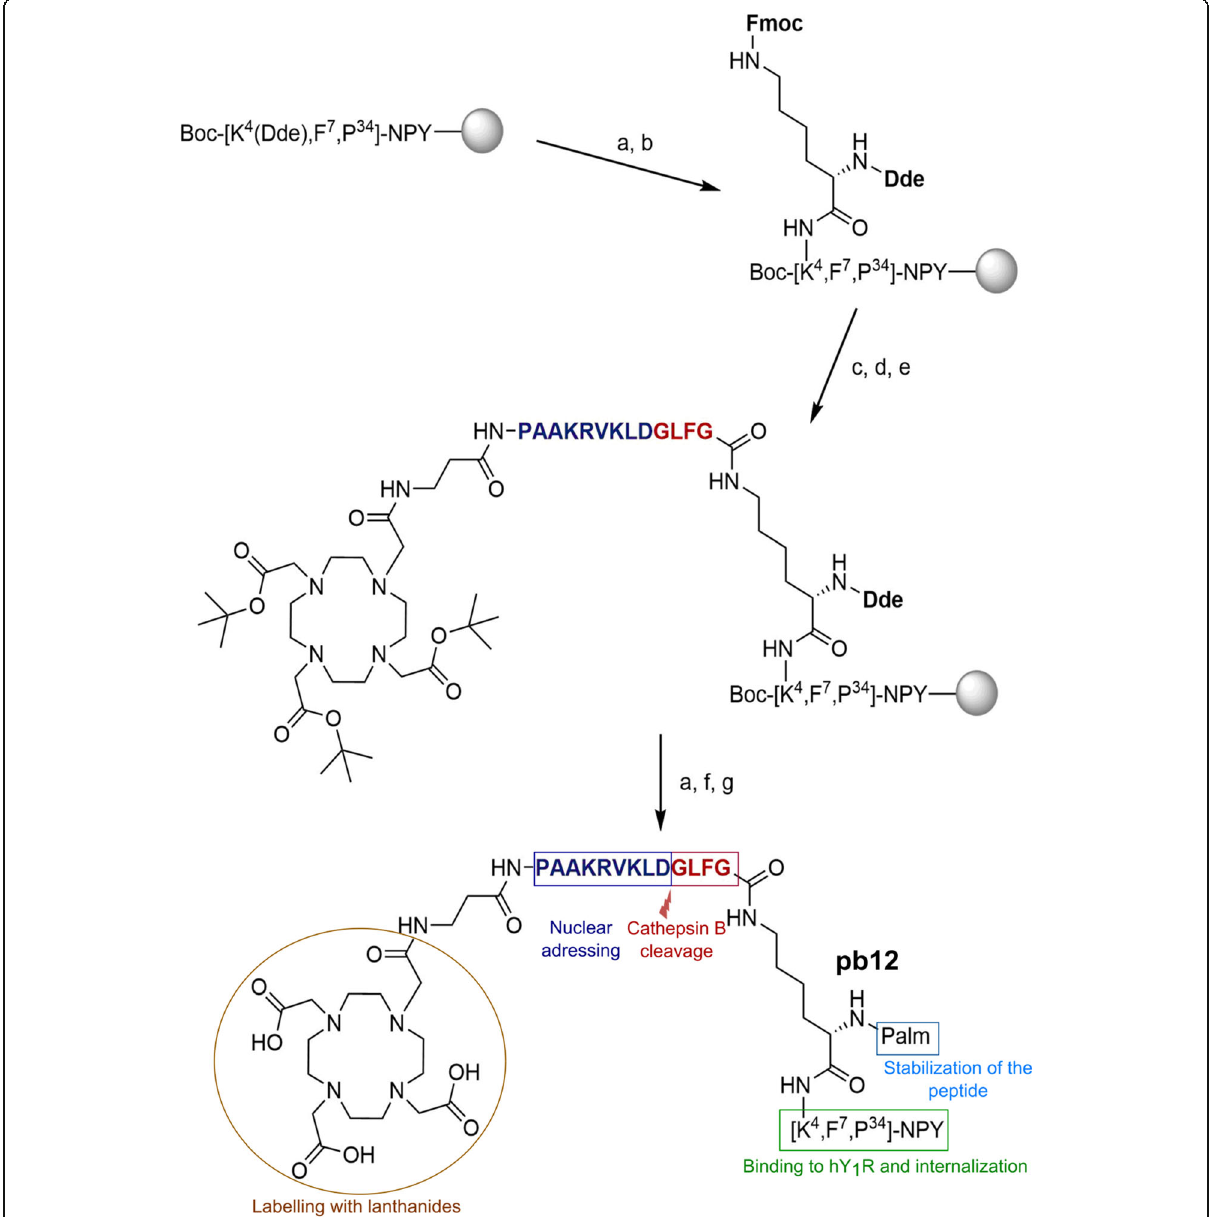
Fig. 1 Synthesis scheme for the hY 1 R-targeted, multifunctional NPY conjugate pb12. Dde, 4,4-dimethyl-2,6-dioxocyclohex-1-ylidenethyl; SPPS, solid phase peptide synthesis; Fmoc, 9-fluorenylmethoxycarbonyl; DMF, dimethylformamide; HOBt, 1-hydroxybenzotriazole; DIC, N,N '- diisopropylcarbodiimide; NLS, nuclear localization sequence; DOTA, 1,4,7,10-tetraazacyclododecane-1,4,7,10-tetraacetic acid; TFA, trifluoroacetic acid; TA, thioanisole; TC, thiocresole; Palm, palmitic acid. The cathepsin B-cleavable linker is marked in red and the nuclear localization sequence in blue. a Dde cleavage, b coupling, c Fmoc cleavage, d extension with β -Ala NLS GLFG sequence, e DOTA coupling, f palm coupling, g full